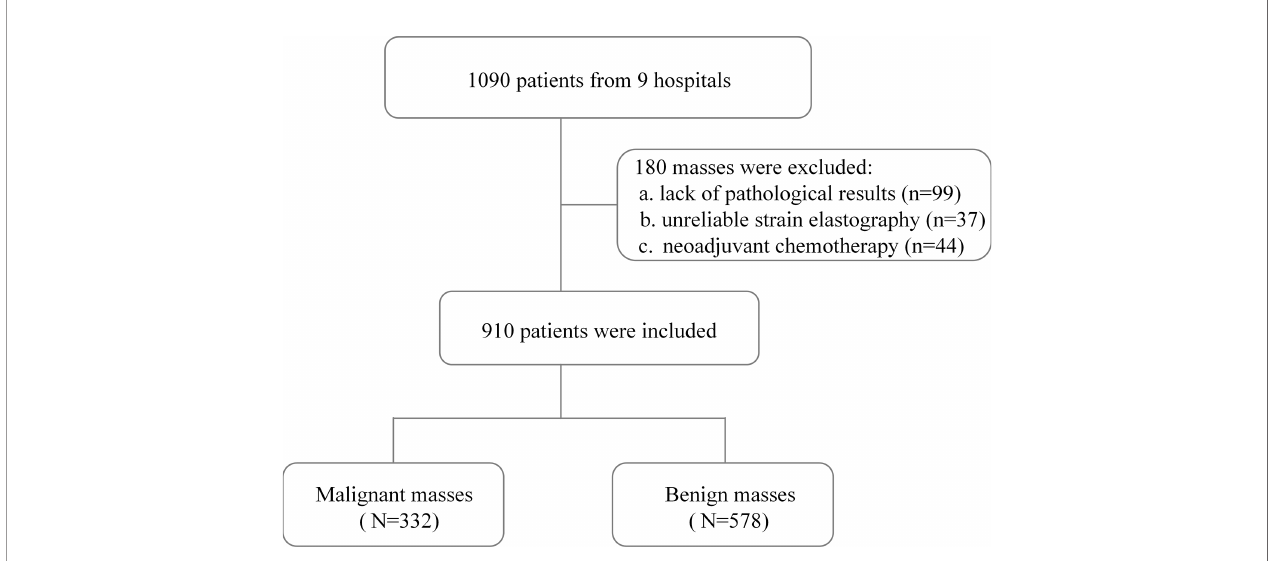
FIGURE 2 | Flowchart of patient selection in the study.